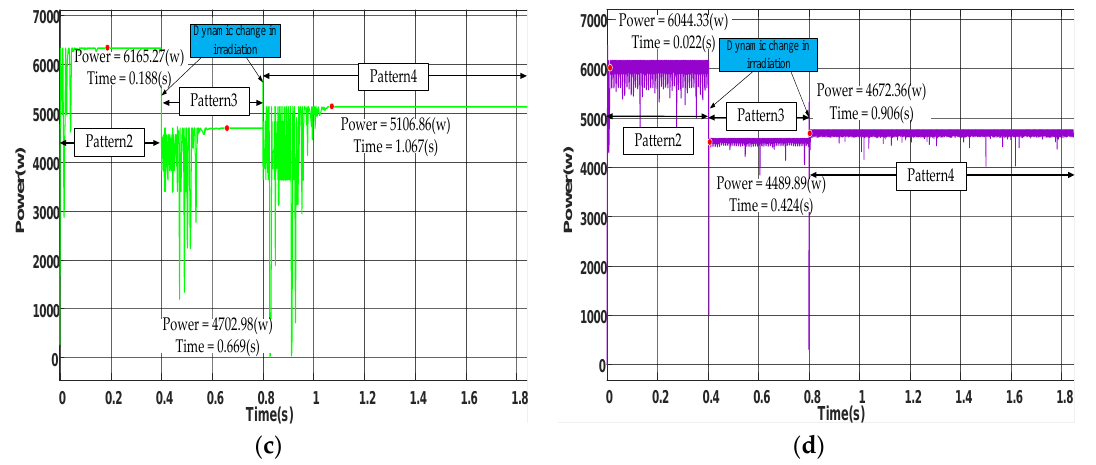
Figure 11. The obtained power by the algorithms over the step changes from pattern 3 and pattern 4. ( a ) TSO; ( b ) ITSO-INC; ( c ) CS; ( d ) INC.